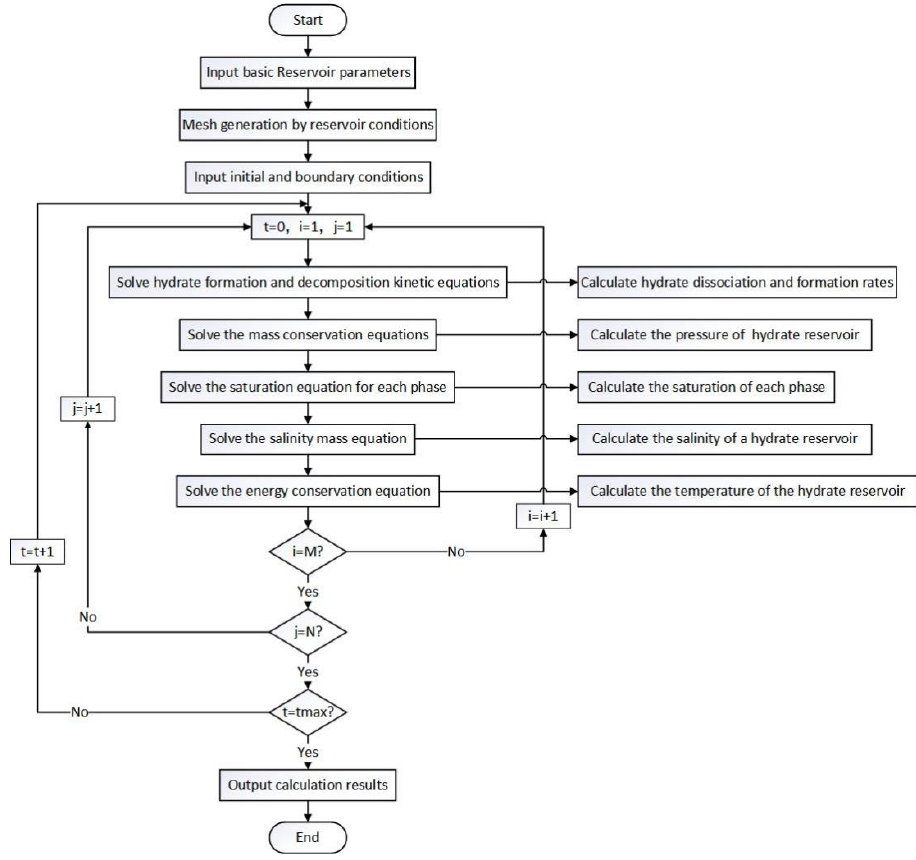
Figure 4. Flow chart of the process of the numerical solution.